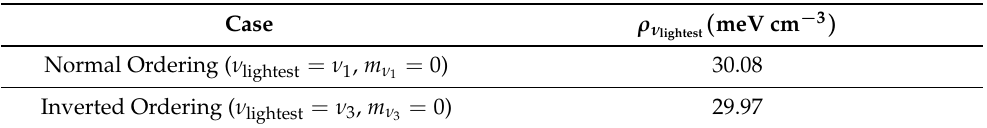
Table 6. Energy density per one degree of freedom for the lightest neutrinos with m ν current homogeneous and isotropic universe including non-thermal distortions due to e ± -annihilation during neutrino decoupling.